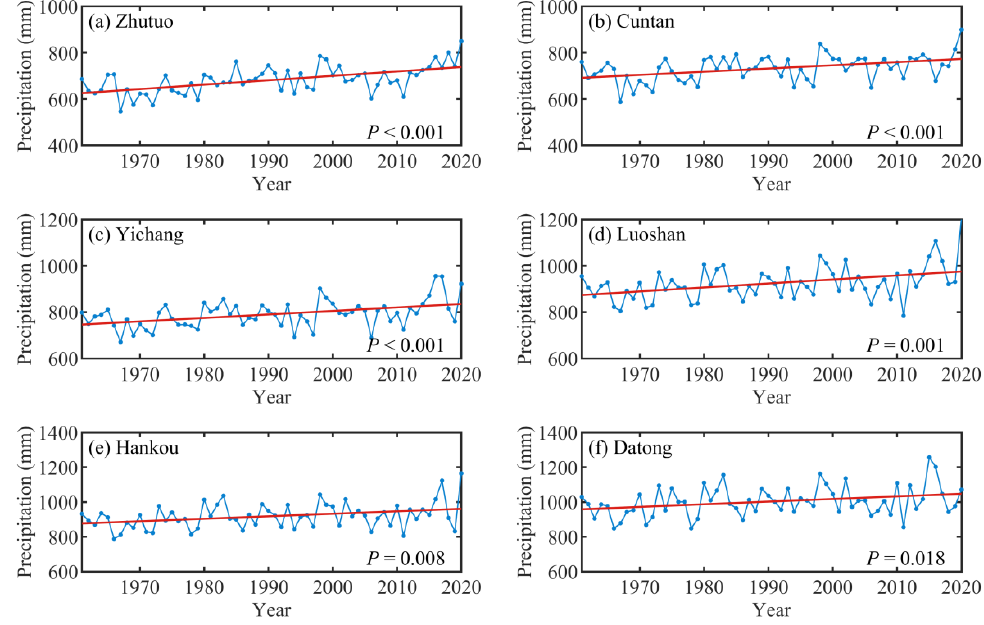
Figure 4. Variation trend of precipitation at six hydrological stations from 1961–2020. Table 2. Precipitation variations during different periods, compared with the natural period 1961– 1980.